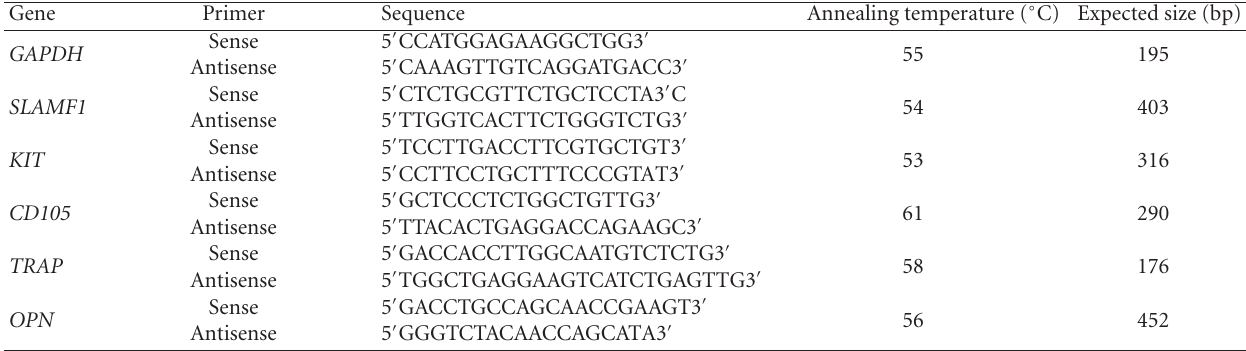
Table 1: Human primer sequences used in